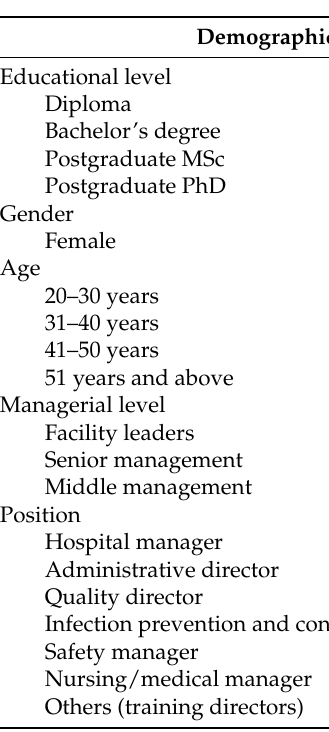
Table 1. Demographic characteristics of